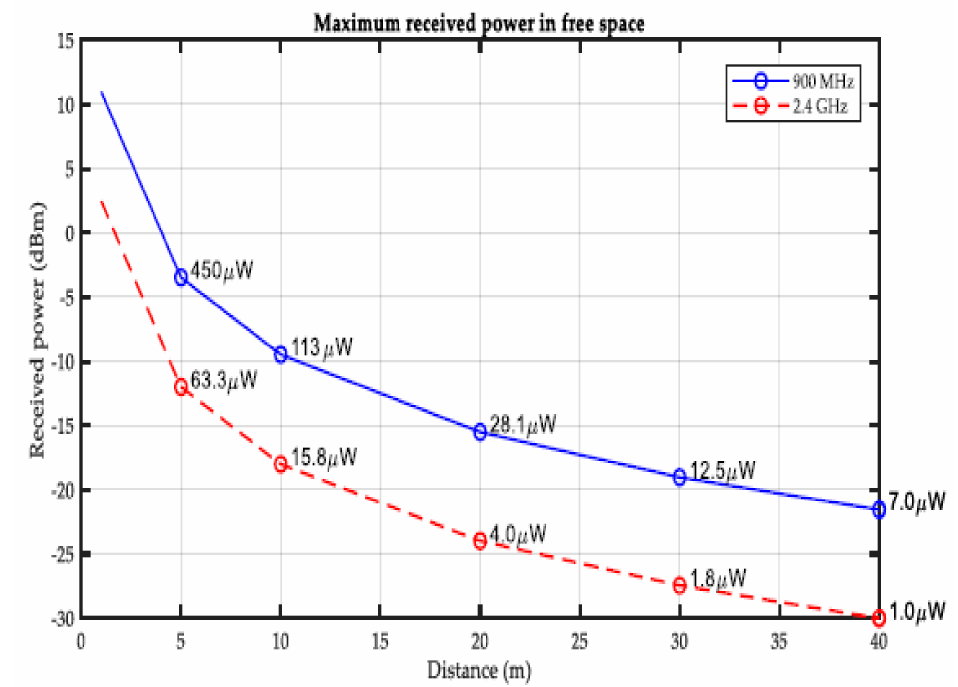
Figure 9. RF energy harvested vs. distance.